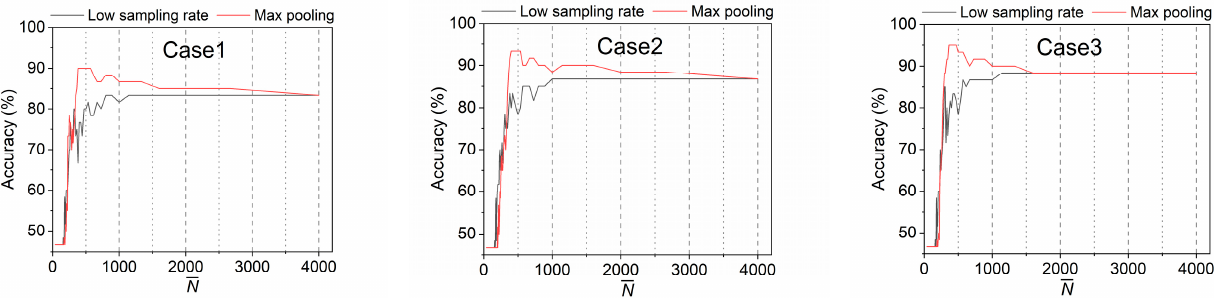
Figure 18. Comparison of low sampling rate and max pooling.